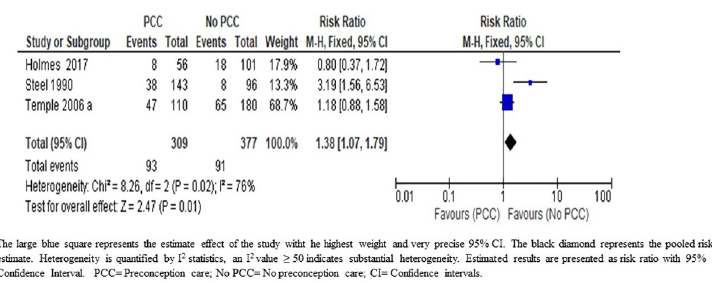
Fig 5. Risk ratio for maternal hypoglycaemia from three studies of women with pre-existing diabetes mellitus who did or did not receive preconception care.